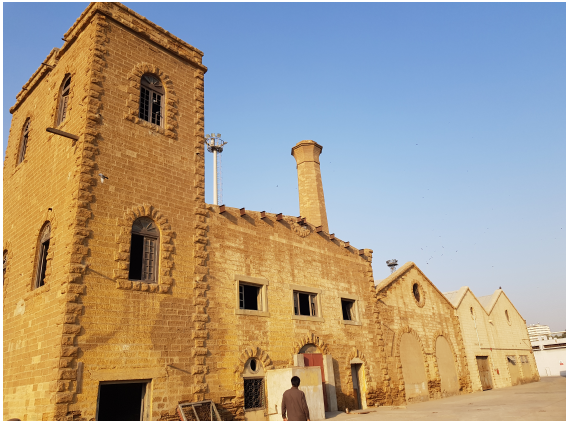
Figure 1. 16–17A Berth east wharf